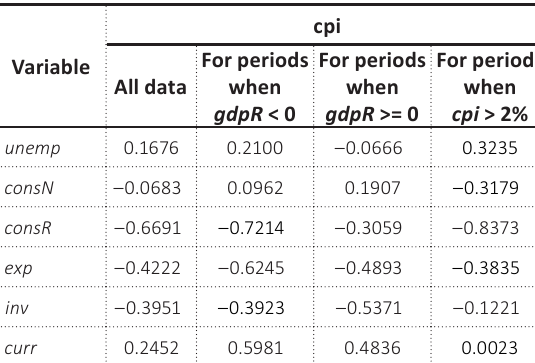
Table 3. The correlation matrix between CPI